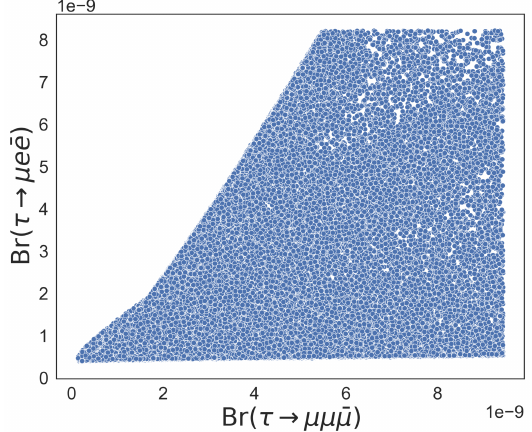
Figure 13 . Scatter plot Br( Z → ¯ τµ ) vs. Br( τ → µµ ¯ µ ) .